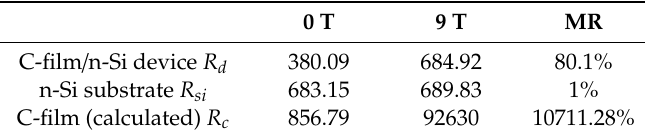
Table 1. The resistances and magnetoresistance (MR) values of the film and substrate in the C-film / n-Si